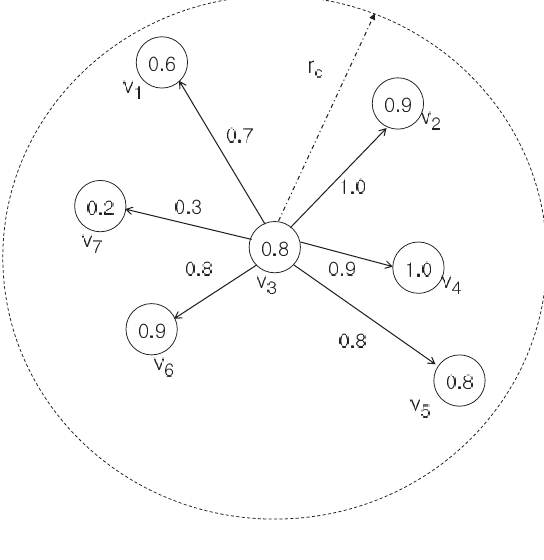
Figure 1. A representation of trust values using a